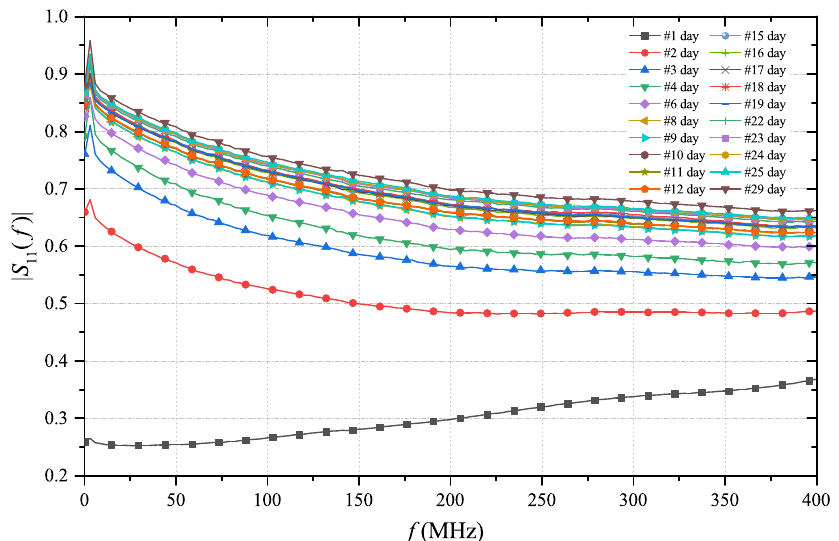
Figure 6. Trend of the S 11 with each passing day in the cubic specimen case in 0–400